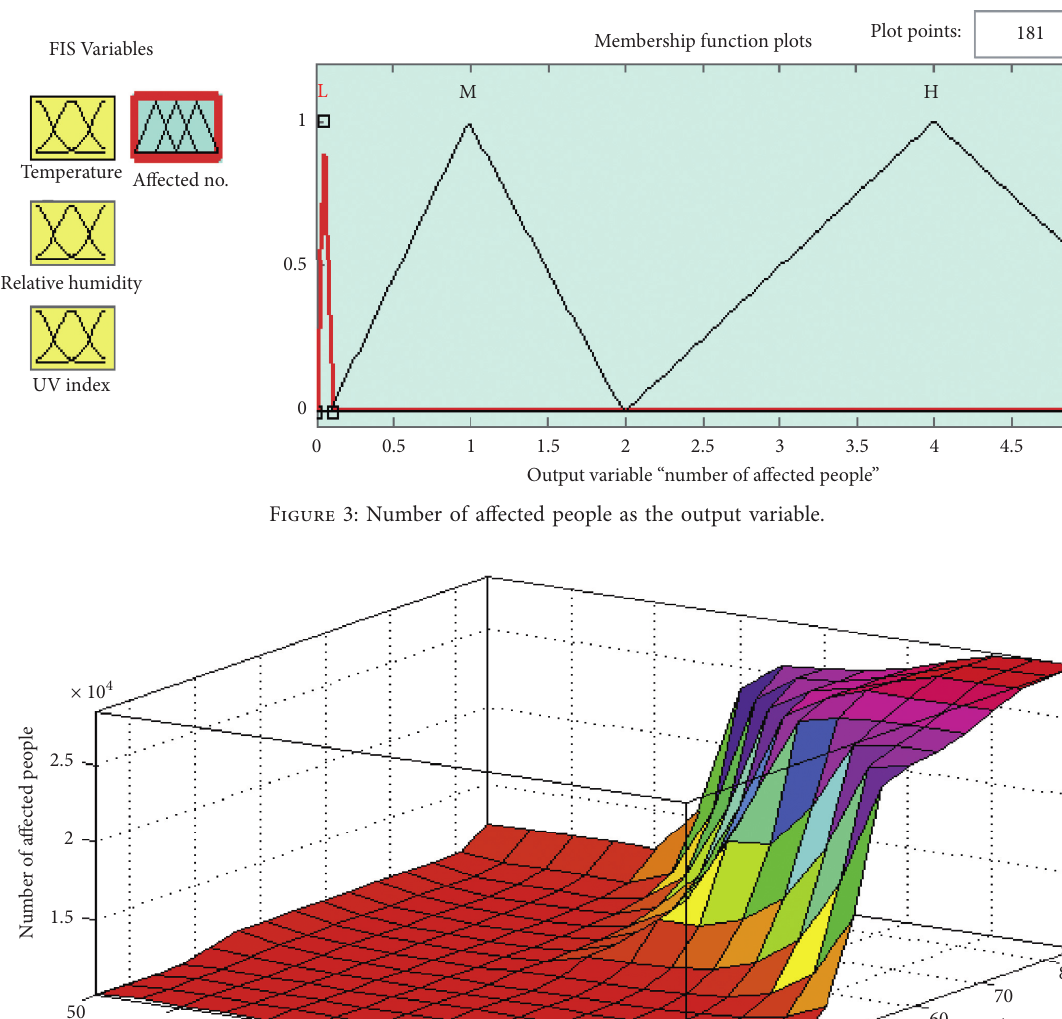
Figure 2: Variables in fuzzy logic.